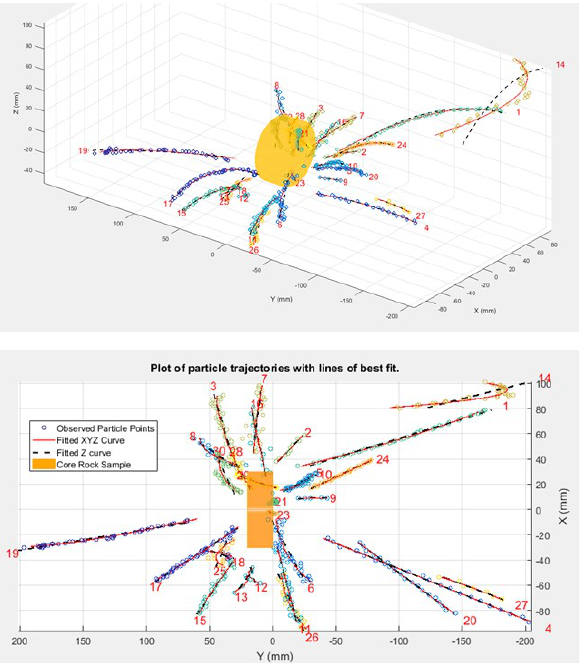
Figure 8. Trajectory curve fits of the progeny particles – perspective (top) and plan (bottom).